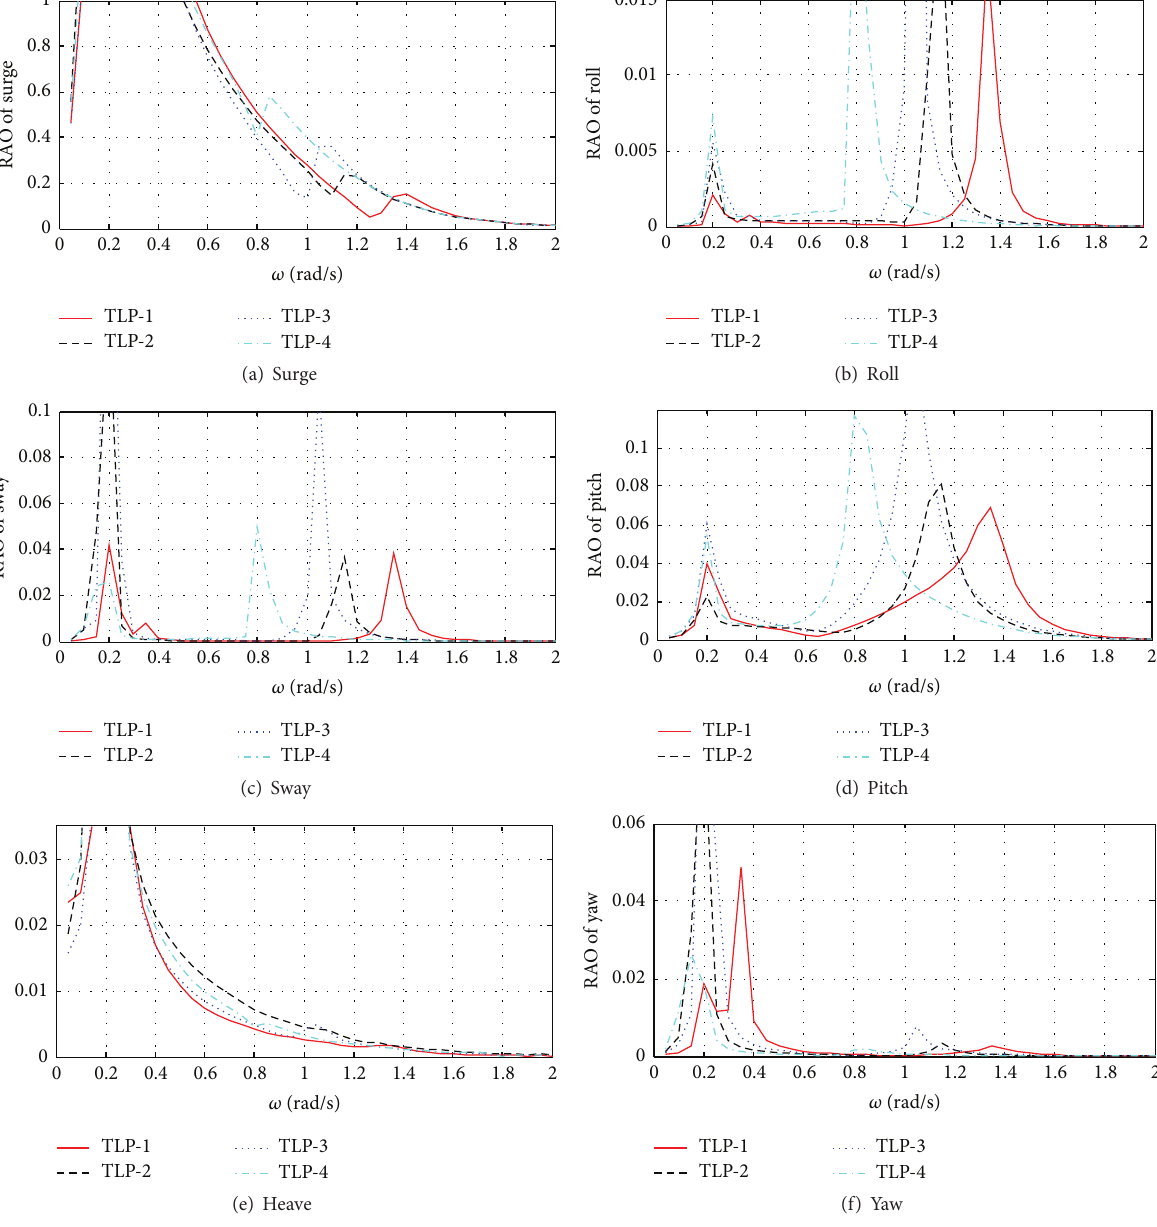
Figure 11: TLP-1, TLP-2, TLP-3, and TLP-4